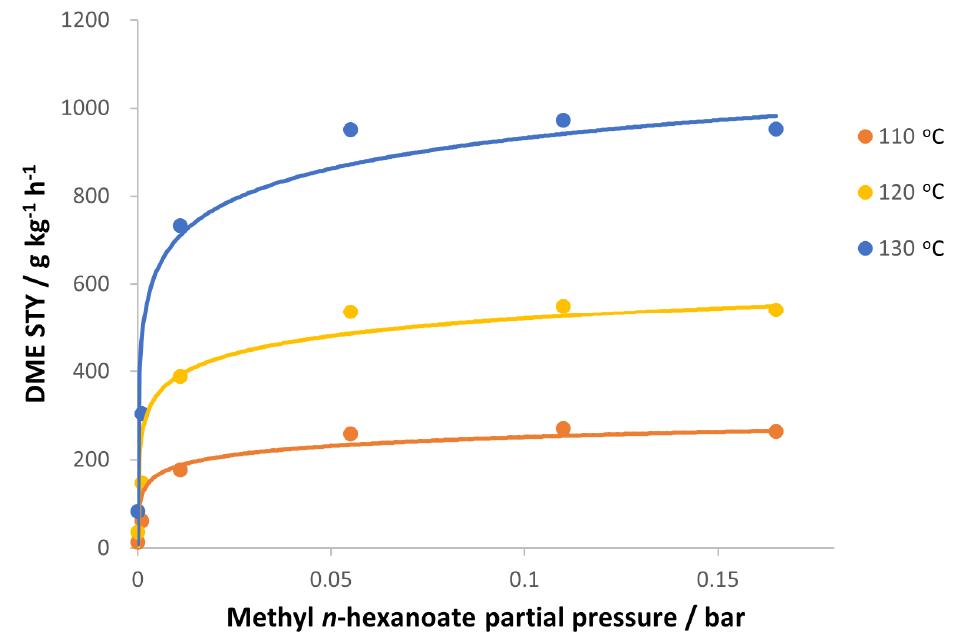
Figure 3. DME STY of the H-ZSM-5 SAR80 catalyst versus the partial pressure of methyl n -hexanoate cofed with 1.1 bar methanol at different reaction temperatures: 110, 120 and 130 °C. The curves are guides for the eye only.